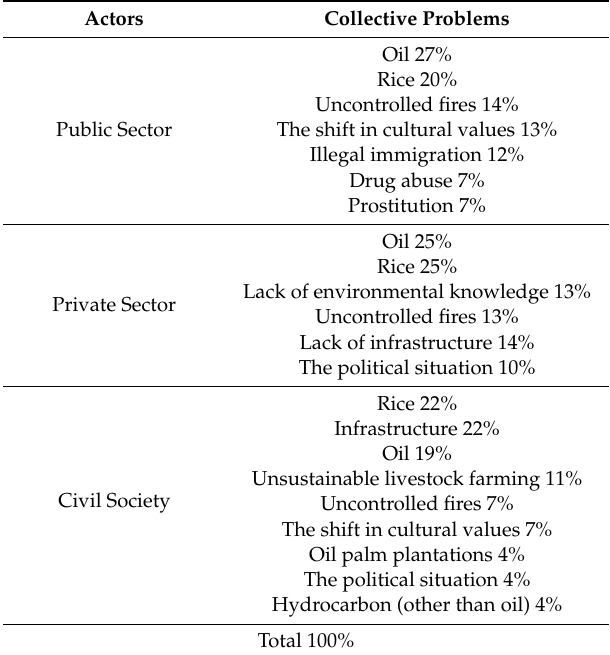
Table 1. The perceived problems